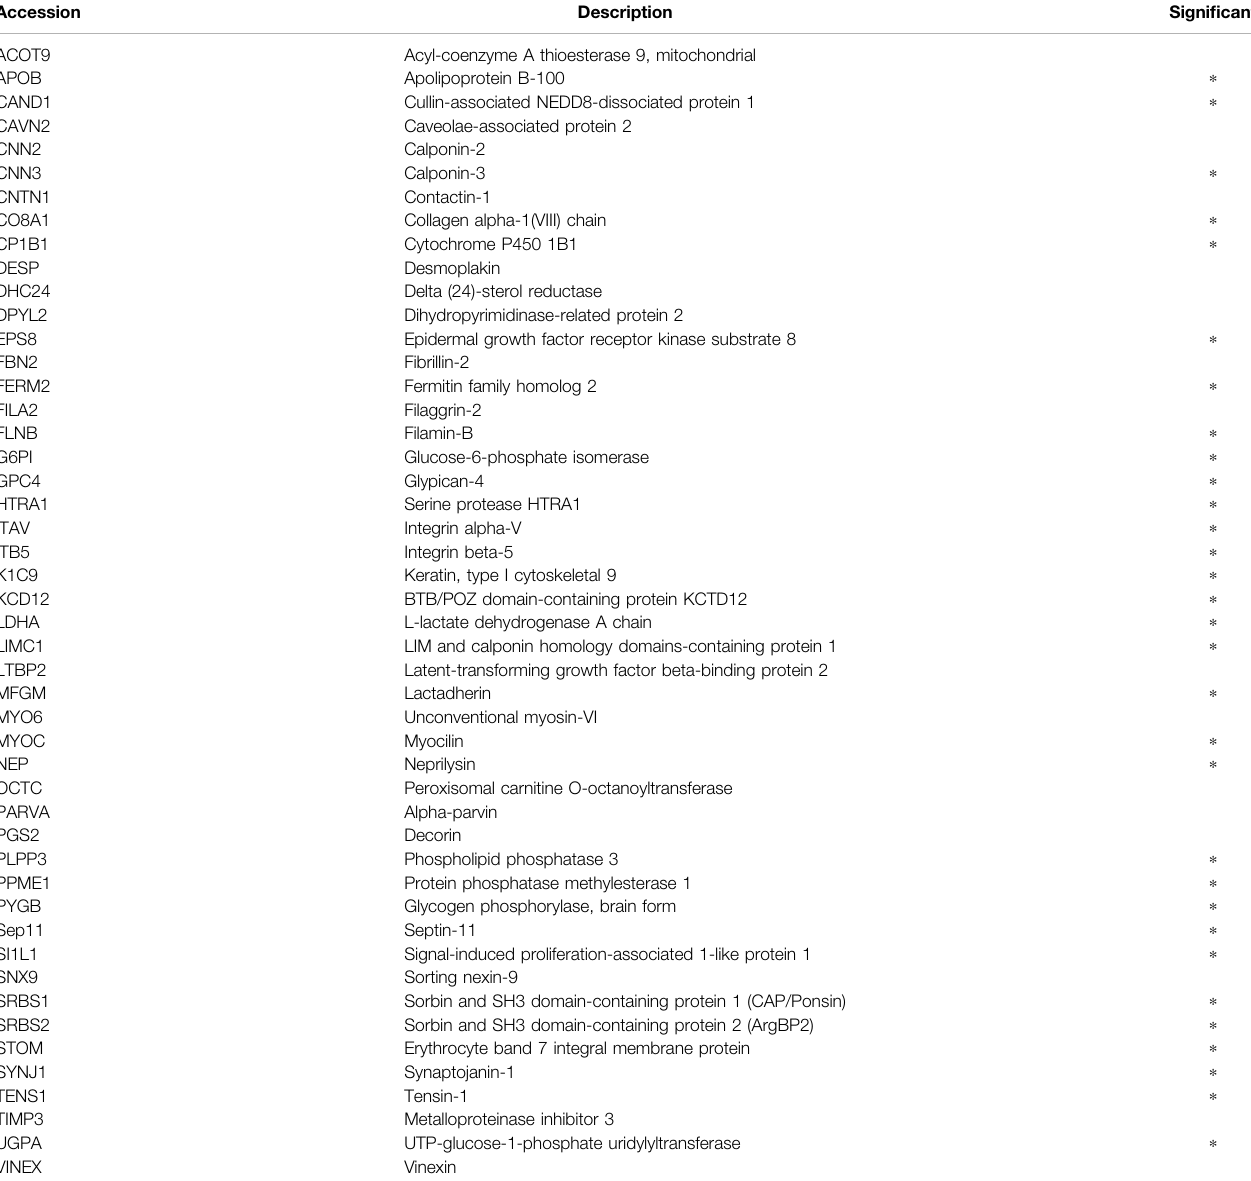
Footnote: Proteins whose levels are elevated by ≥ 2-fold in response to Dex treatment are listed. “ * ” indicates a signi fi cant ( p < 0.05) increase in the level of identi fi ed protein in nuclear extracts from Dex treated human TM cells relative to control human TM cells.